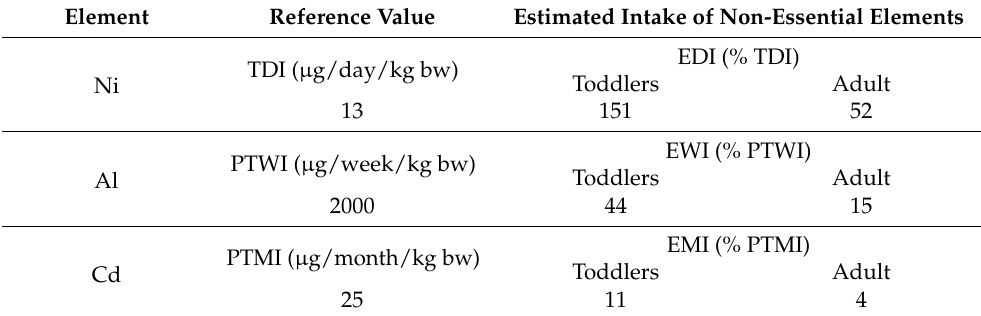
Table 8. Estimated daily (EDI), weekly (EWI) and monthly (EMI) intake, expressed as % of toxico- logical guidance values of Ni, Al and Cd, considering the consumption of 100 g/day (adults) or 50 g/day (toddlers) of nfuma